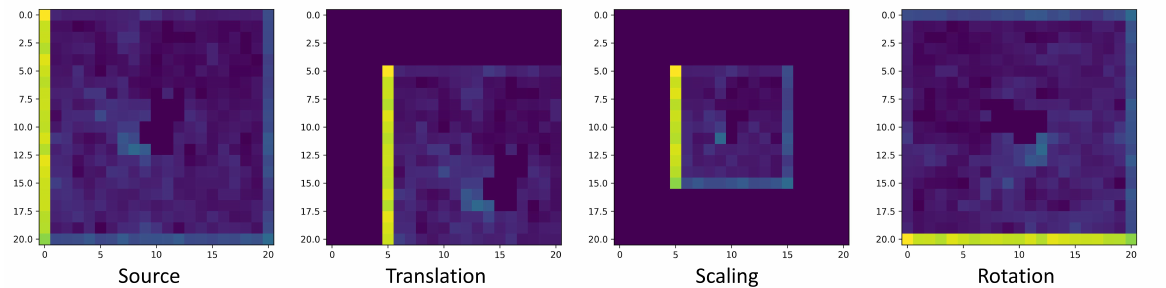
Figure 3. Three kinds of affine transformation.